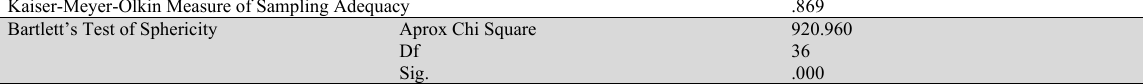
Table 2 : Organizational Commitment Validity Result (used CFA analysis) Kaiser-Meyer-Olkin Measure of Sampling Adequacy